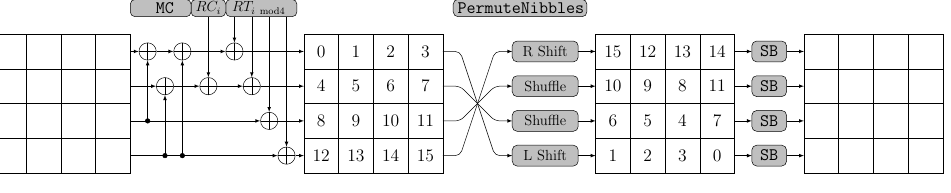
Figure 3: Structure of CRAFT